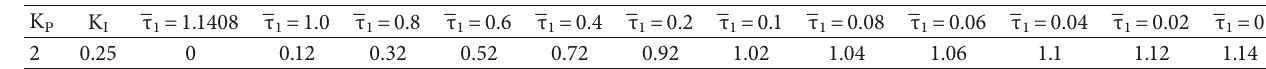
− 2, the highest acceptable delay bound τ ̅ 1